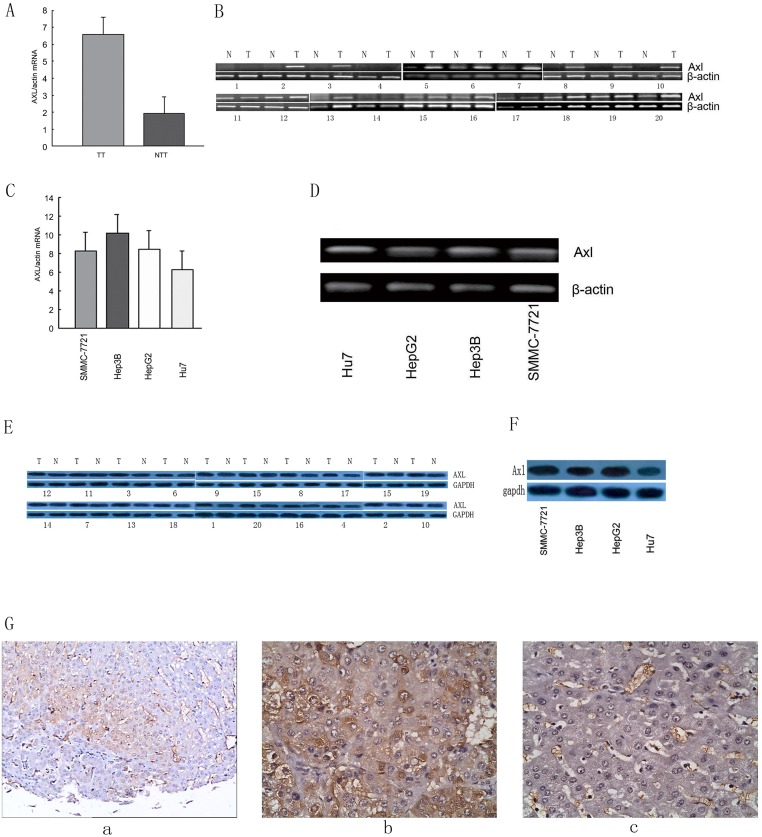
Expression of AXL in HCC specimens and cell lines.Results of examining Axl expression in tumor tissues and paired non-tumorous tissues by real-time RT-PCR (A), RT-PCR (B) and western blot (E), respectively. Results of examining Axl expression in SMMC-7721, Hep3B, HepG2, Hu7 cell lines by real-time RT-PCR (C), RT-PCR (D) and western blot (F), respectively. β-actin was used as internal control. G: Representative images of immunohistochemical staining of AXL in paired tumor (b) and non-tumorous tissues (c). a: the lower magnification field. Bars, ±SD.